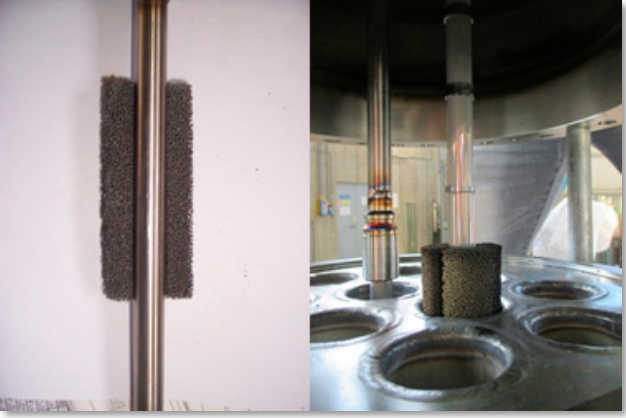
Figure 5. R-02 reactor catalyst arrangement .